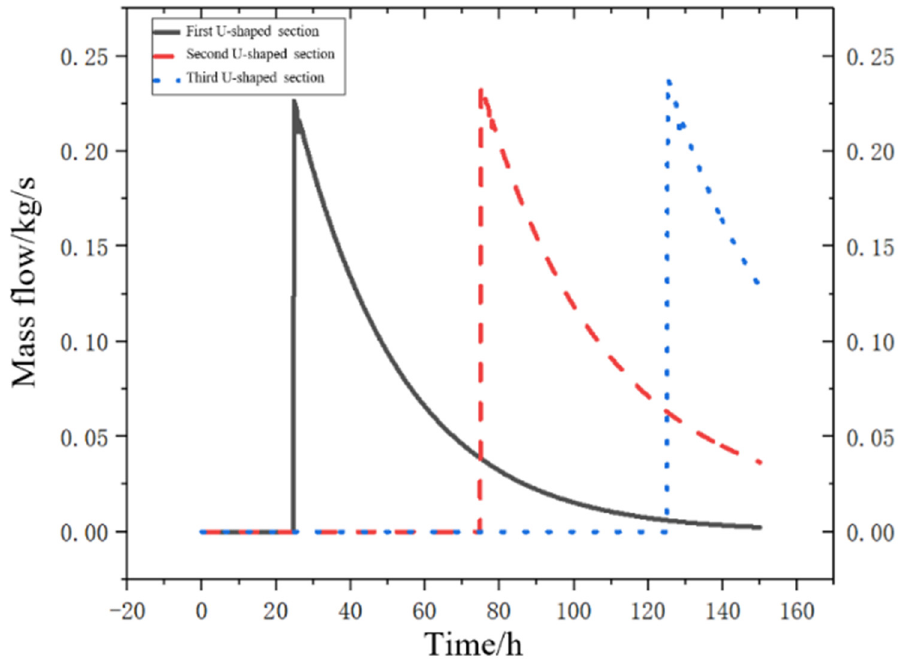
Figure 16. Variation in the mass flow rate of a gas section during gas bubble crushing in the multi-pipe simulation example.